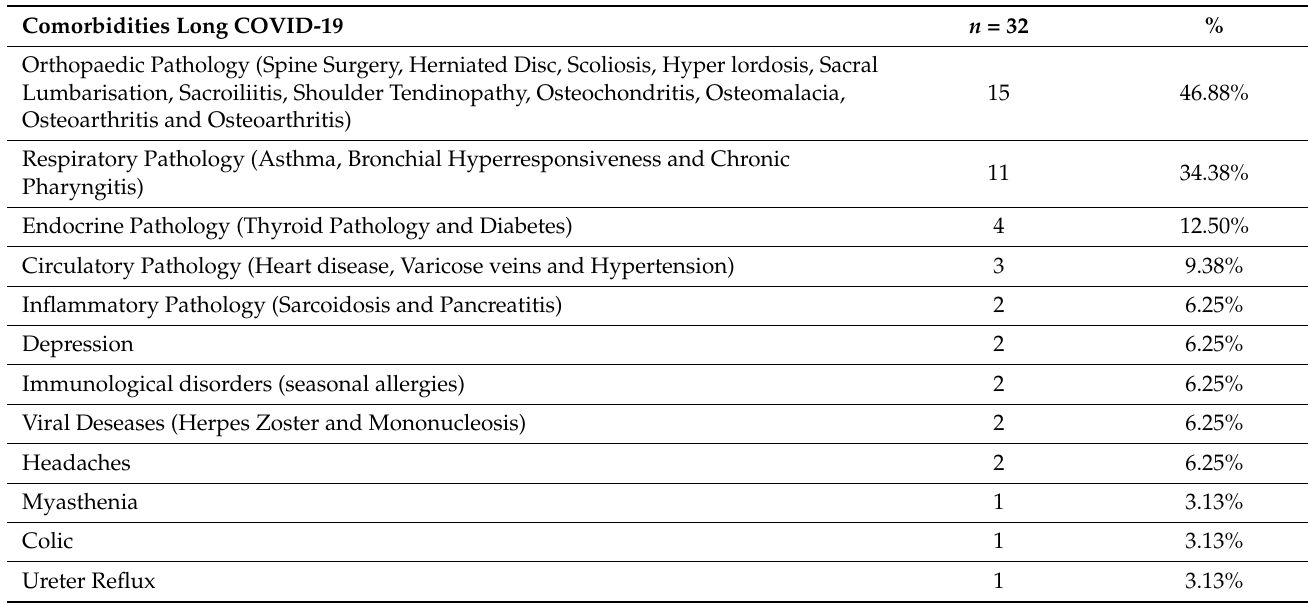
Table 2. Comorbidities distribution.